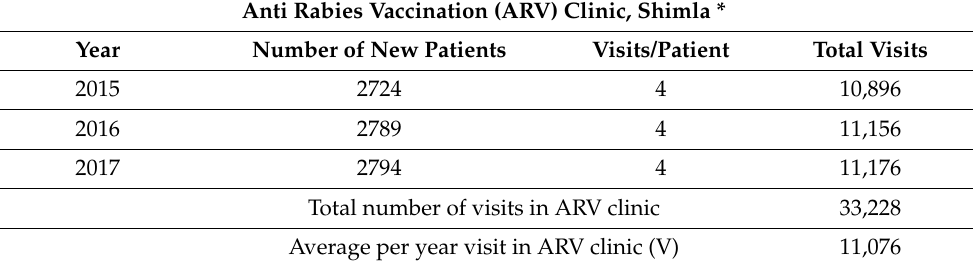
Table A8. Total number of visits.